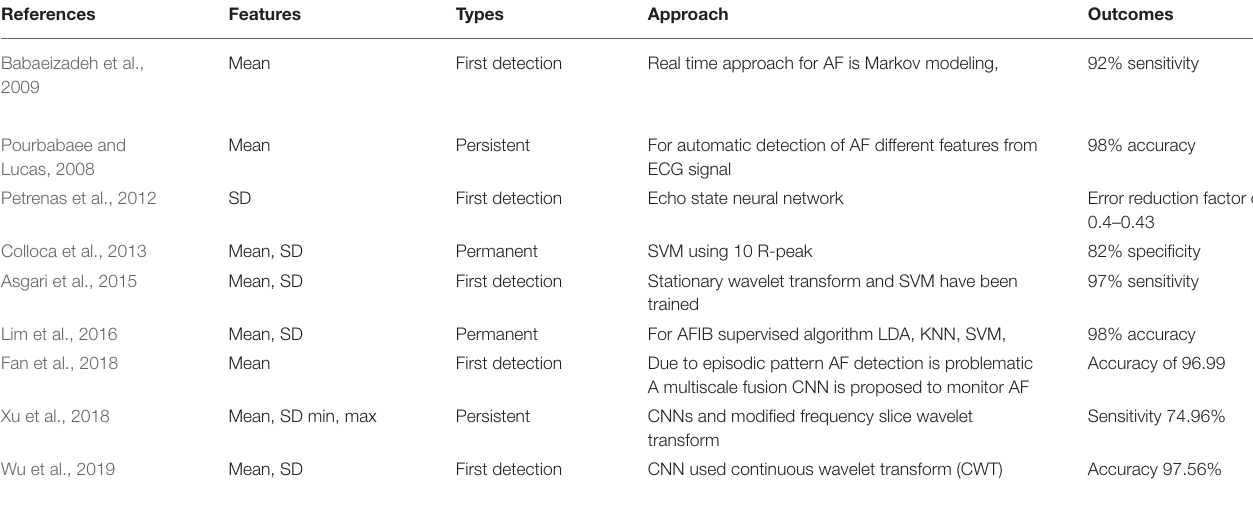
TABLE 1 | Comparison of AF and skin hydration